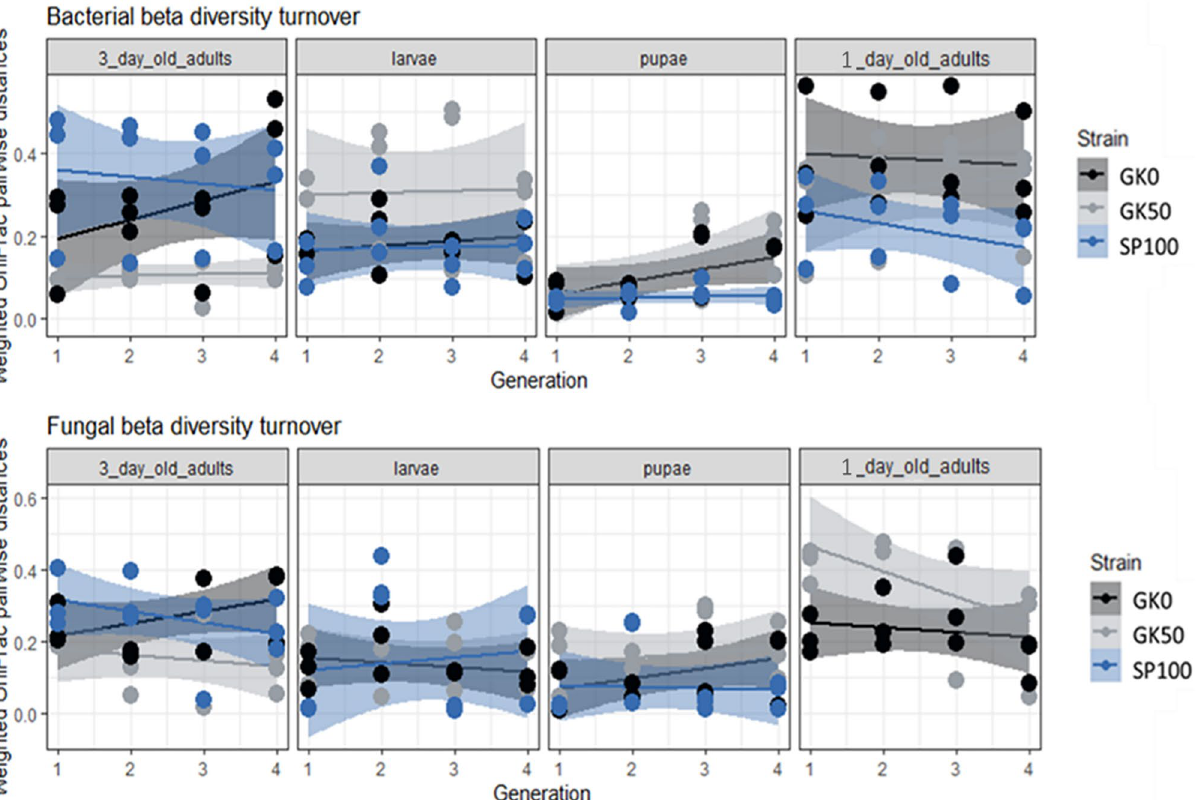
Figure 4. Weighted UniFrac pairwise distances for all housefly developmental stages of three strains over four consecutive generations as a metric for beta diversity turnover for bacterial and fungal communities. Beta- diversity patterns showed no significant shifts between housefly generations. Lines show the linear regression for each housefly strain beta diversity values across generations. The shaded field around the lines stands for the standard error of the linear regression. Beta diversity did not shift significantly across generations for any housefly